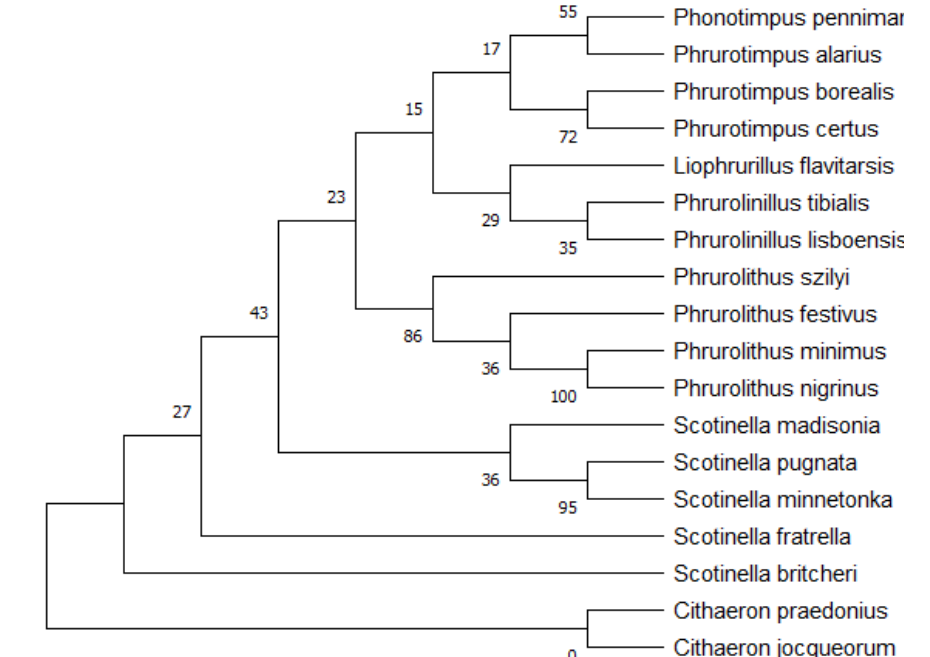
Figure 3. Phylogenetic tree of the family Phrurolithidae based on mitochondrial cytochrome oxidase subunit I (600 bp) nucleotide sequences that are available in databases and the coxI sequences generated in the present study ( P. pennimani , Ppen_DNA_Mix GenBank OP001985; Ppen_DNA_female GenBank OP001986).